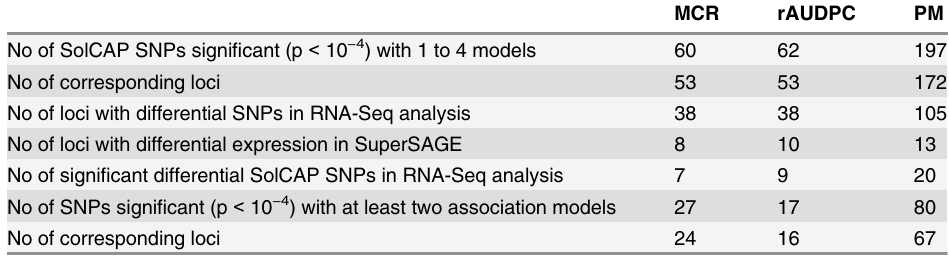
Table 5. Number of SolCAP SNPs and corresponding loci showing putative associations with MCR, rAUDPC and PM based on different ranking